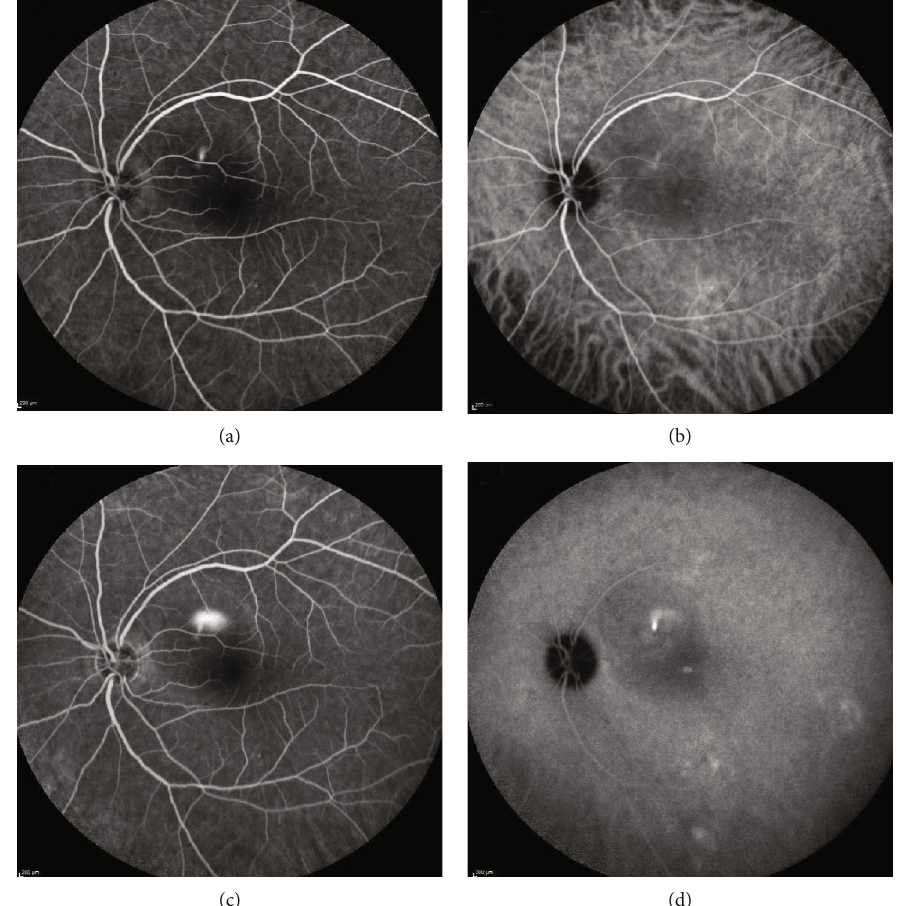
Figure 2: Simultaneous fl uorescein angiography and indocyanine green angiography with a smokestack pattern. Early (a, b) and late (c, d) phase images are